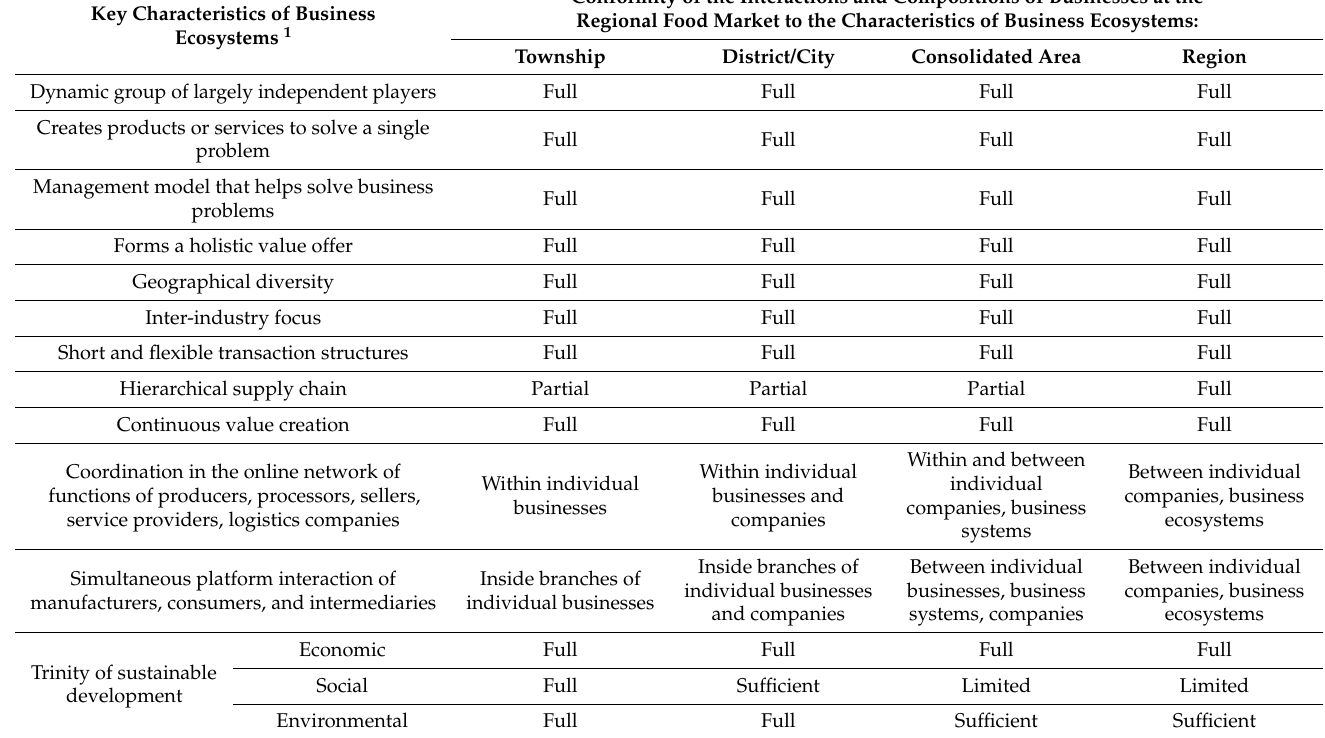
Table 1. Correspondence of interactions and compositions of the social infrastructure organizations, agribusiness, forestry, and construction complexes as well as industrial infrastructure with the basic characteristics of the business ecosystems of the region and the trinity of sustainable